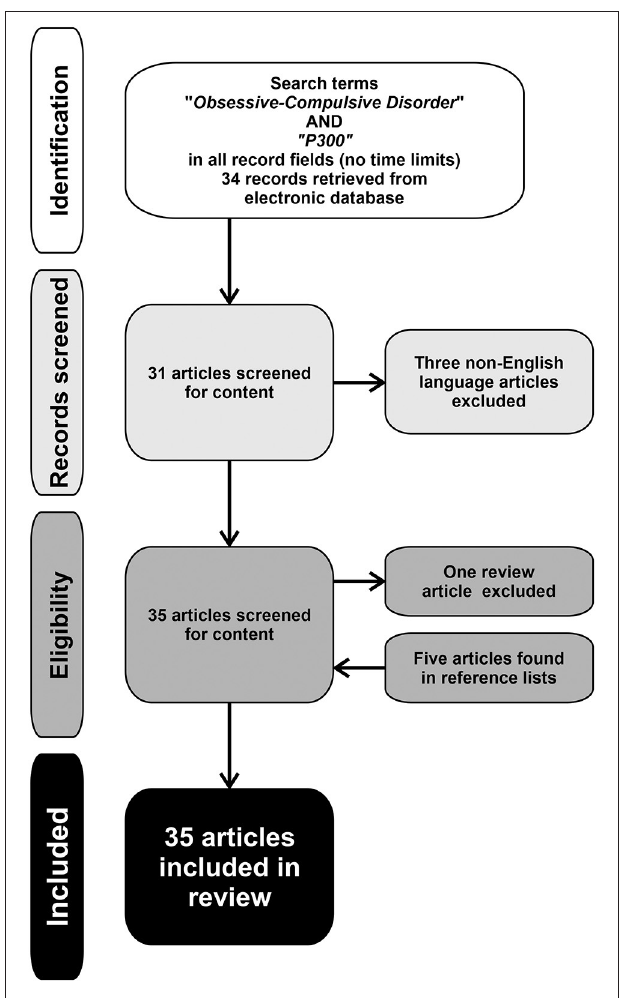
FIGURE 1 | Flow of information through the different phases of the review process.